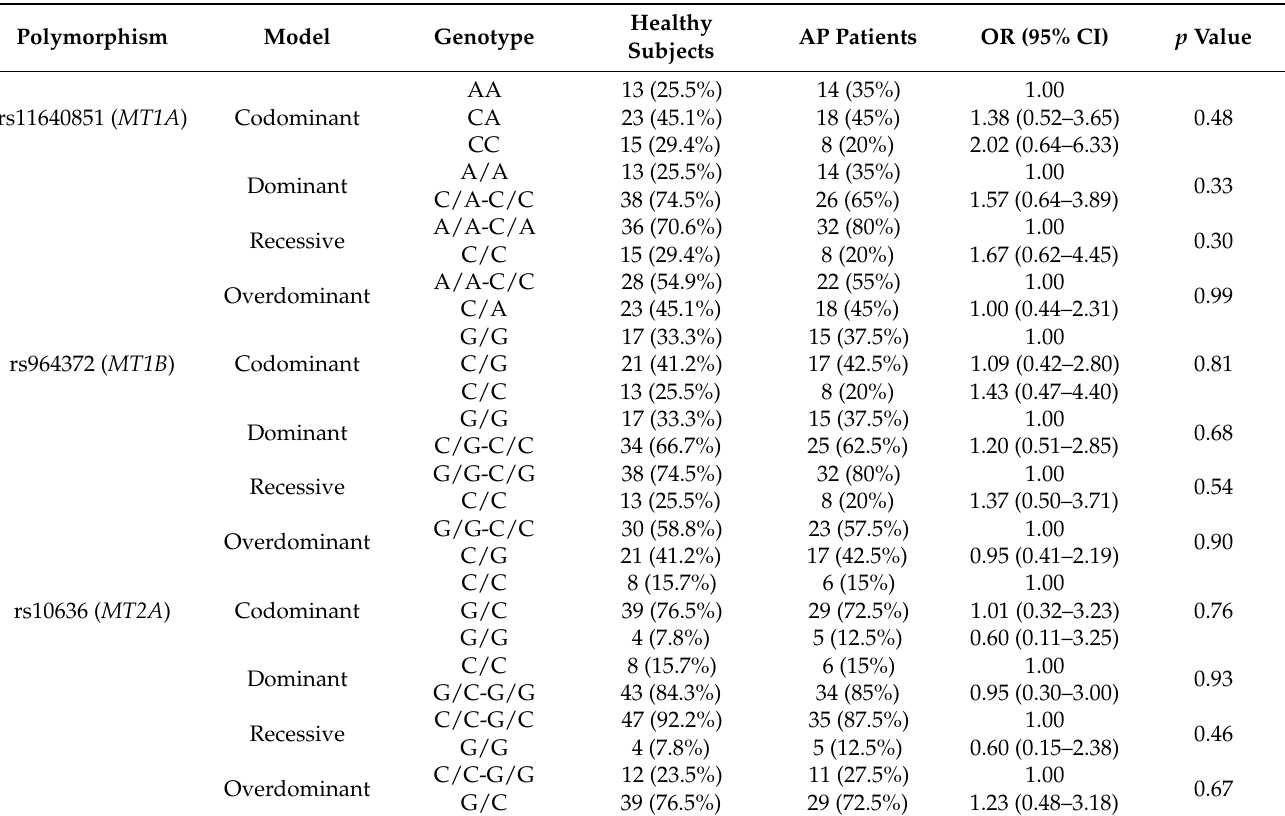
Table 2. MT genotype frequency for SNPs rs11640851, rs964372 and rs10636 in patients with acute pancreatitis and healthy